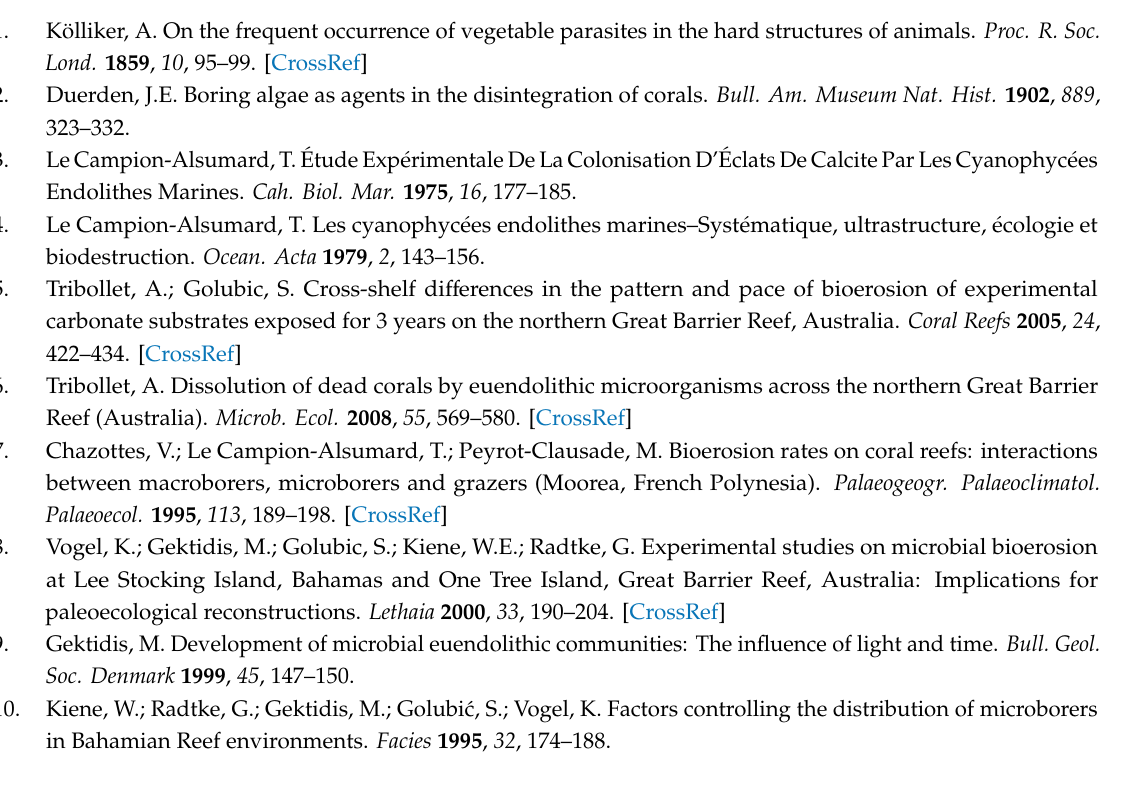
Figure S1: Rarefaction curves of tile communities, Figure S2: PCoA analysis of bacterial and cyanobacterial community composition, Figure S3: Phylogenetic placement of euendolith clusters and colonization dynamics, Figure S4: ASV di ff erential abundance analysis of 3-month and 9-month colonized tiles. Table S1: BIOM tables containing sequences counts for each euendolith cluster at all 3 time points and steady-state climax